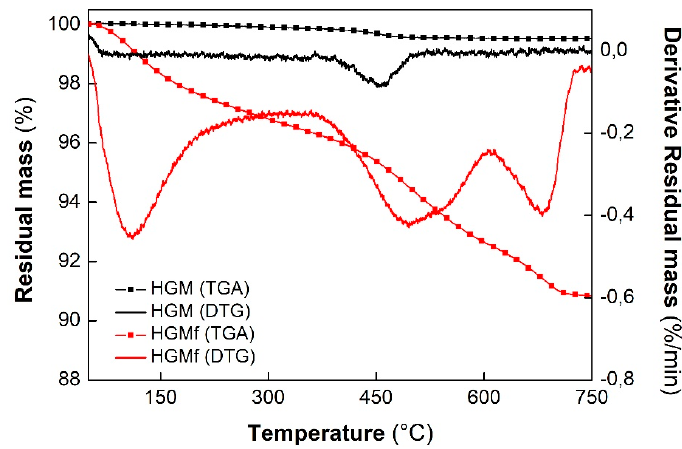
Figure 4. Thermogravimetric analysis (TGA) and derivate thermogravimetry (DTG) curves of naked HGM (black line) and silanized HGMf (red line).